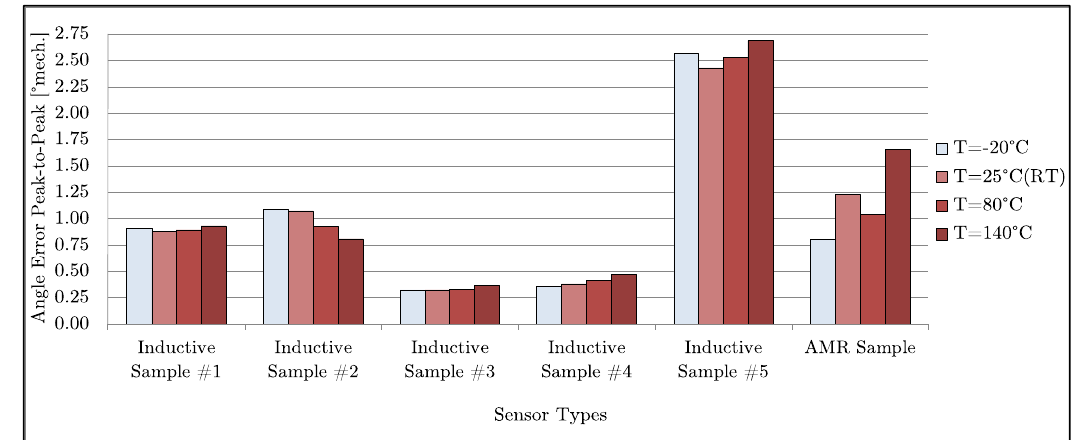
Figure 18. Inductive- and AMR-based sensor accuracy characteristics in the sensor systems’ sweet spots at different operational ambient temperatures.